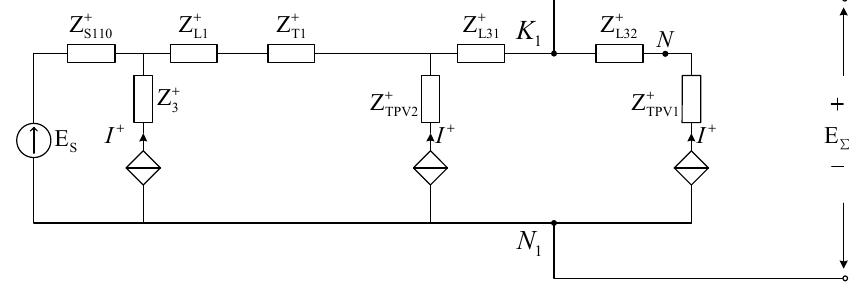
Figure 13. Positive sequence network of the equivalent integrated power supply.